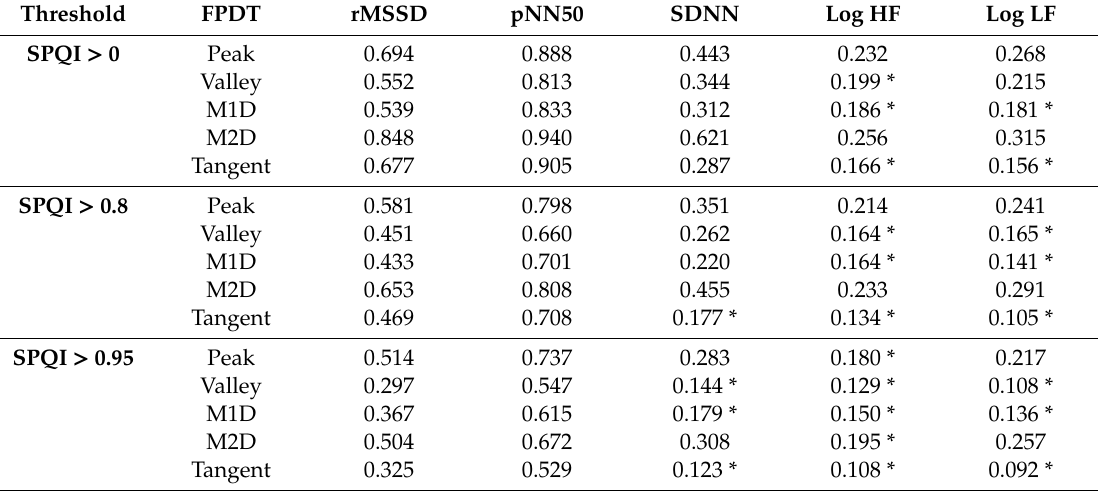
Table 5. Bland–Altman ratios between the results generated by smartphone PPG and